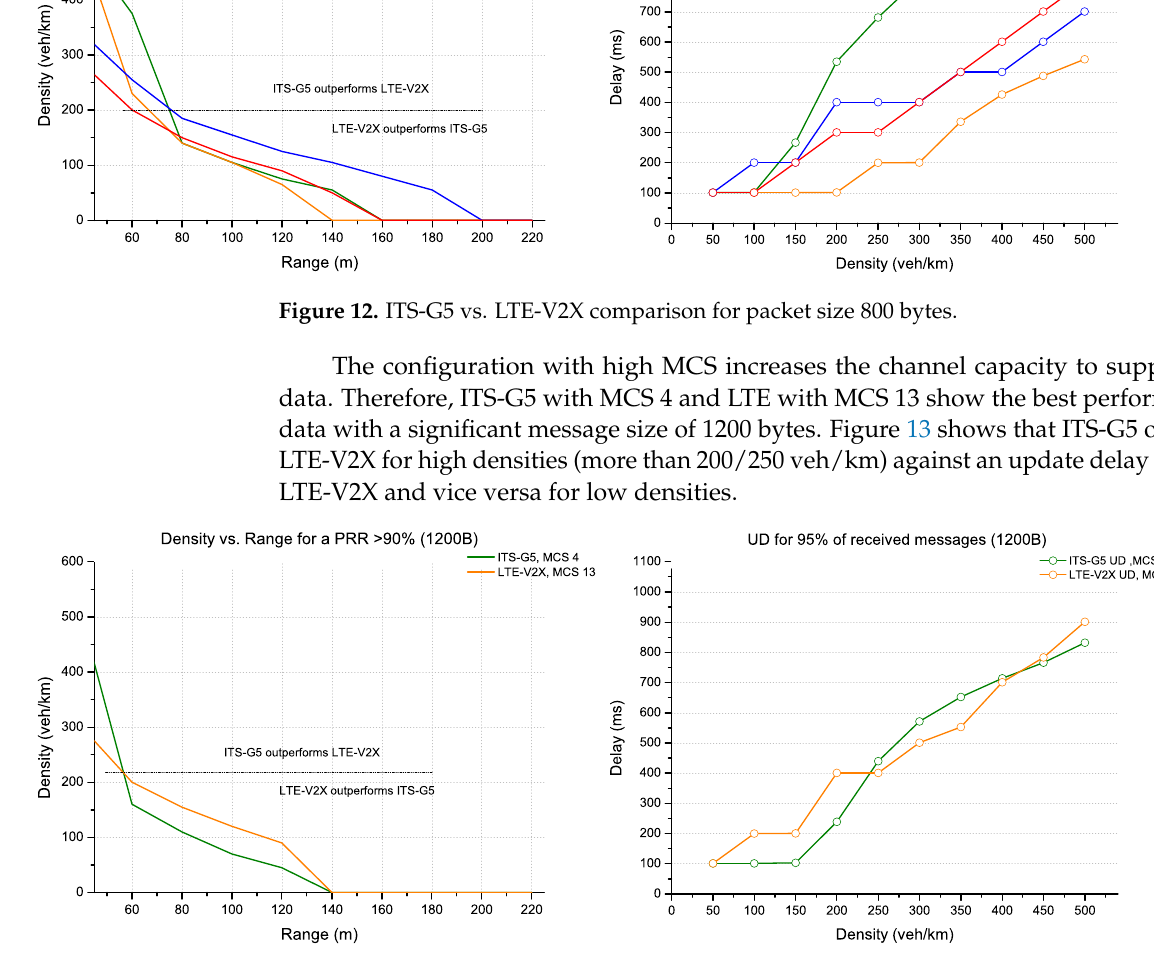
Figure 13. ITS-G5 vs. LTE-V2X comparison for packet size 1200 bytes. The obtained results allow assessing the behaviour of both technologies under the same conditions. LTE-V2X shows a better range at low density than ITS-G5. Still,